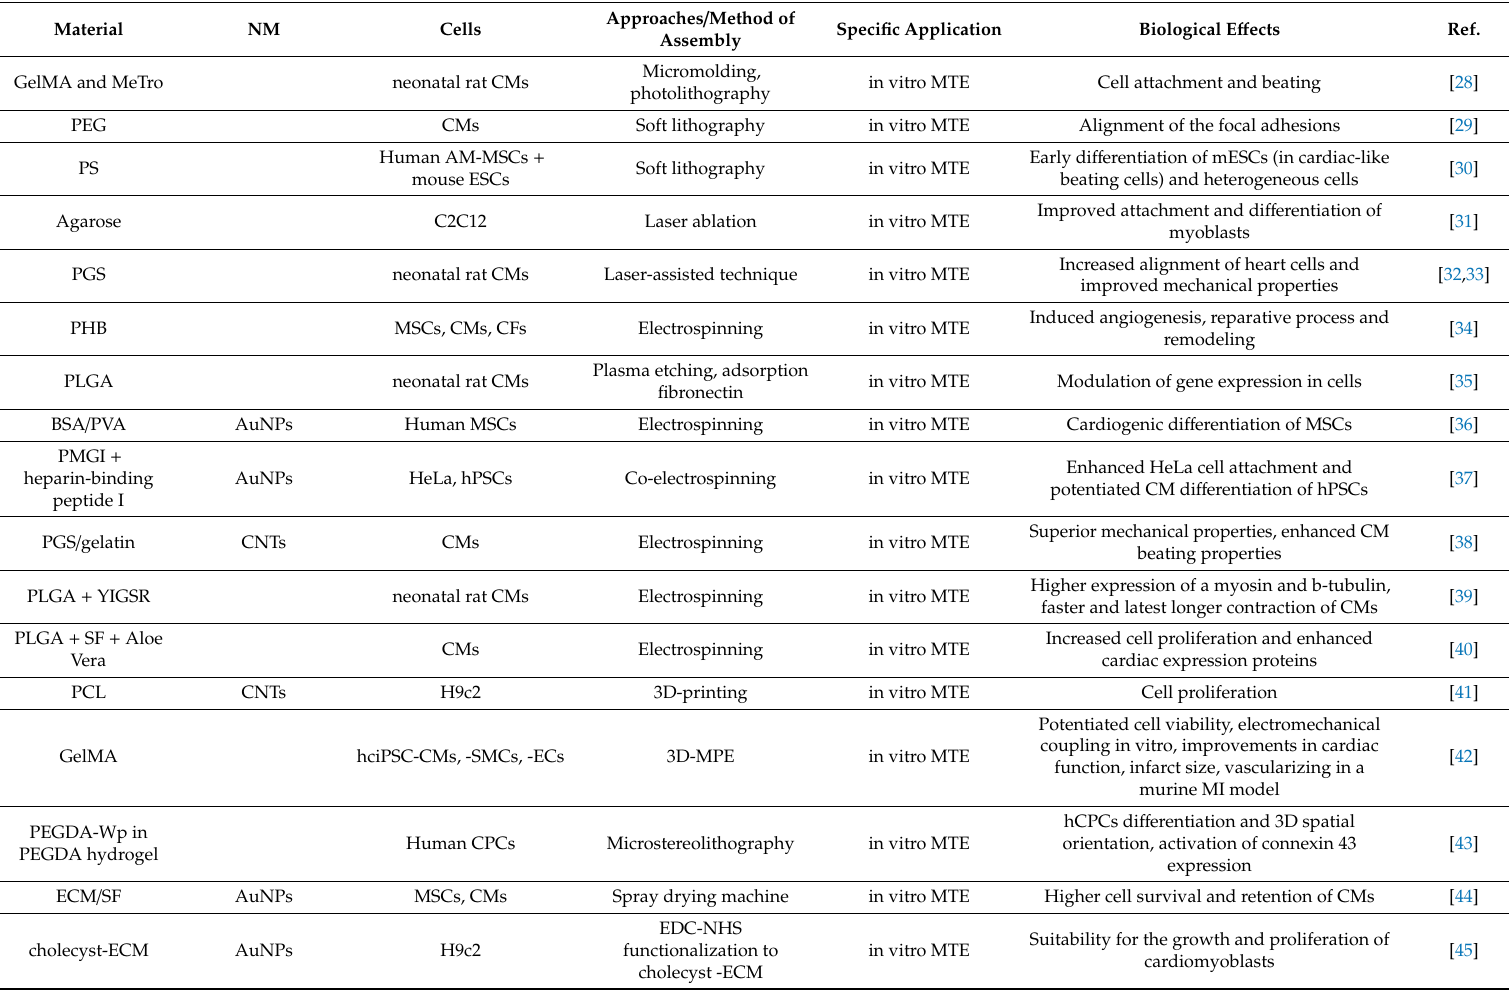
Table 1. Representative examples of sca ff old materials, cells and micro-nanofabrication techniques for myocardial tissue engineering (MTE) with their relevant biological e ff